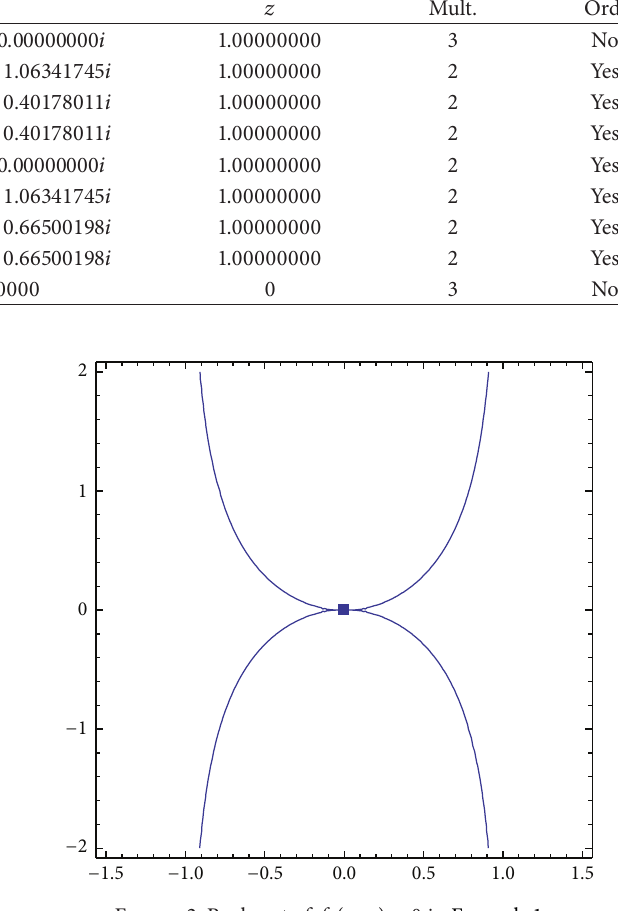
Figure 1: Real part of 𝑓 1 (𝑥,𝑦) = 0 in Example 1. Figure 2: Real part of 𝑓 2 (𝑥,𝑦) = 0 in Example 1.